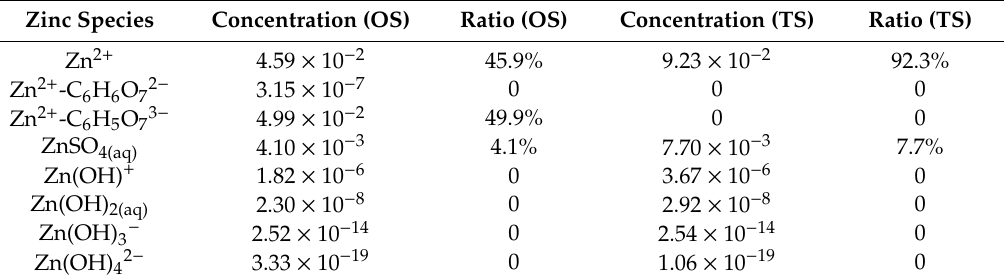
Table 1. Distribution of soluble zinc species in solution before pH